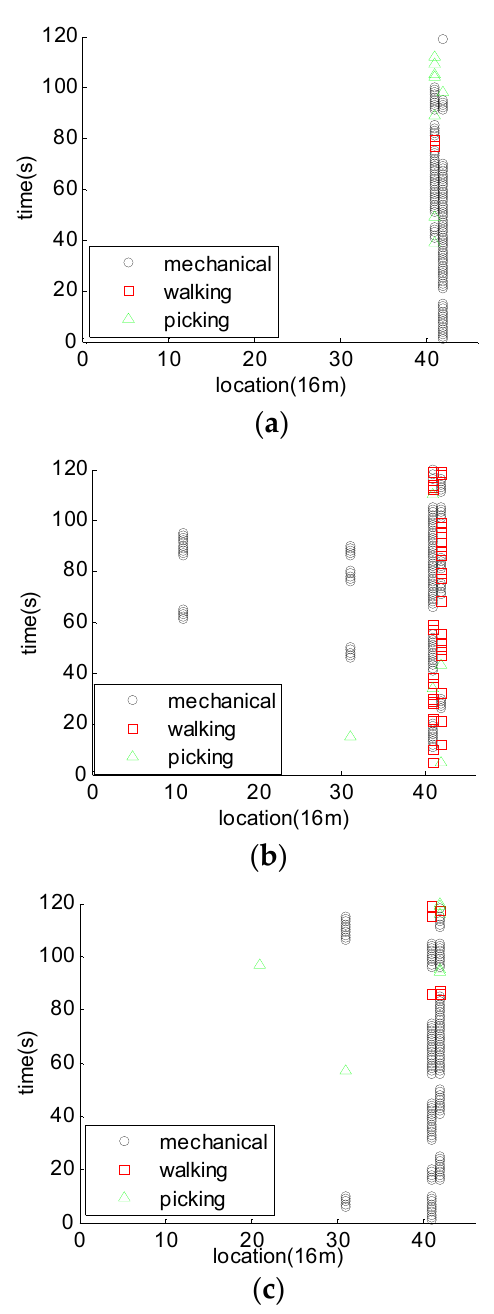
Figure 13. The identification results of mechanical drilling signals. ( a ) The first group of mechanical drilling signals; ( b ) The second group of mechanical drilling signals; ( c ) The third group of mechanical drilling signals.